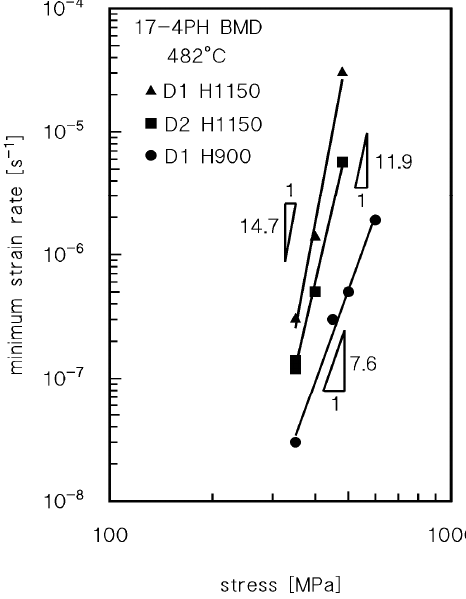
Figure 5. Minimum creep rate as a function of applied stress.